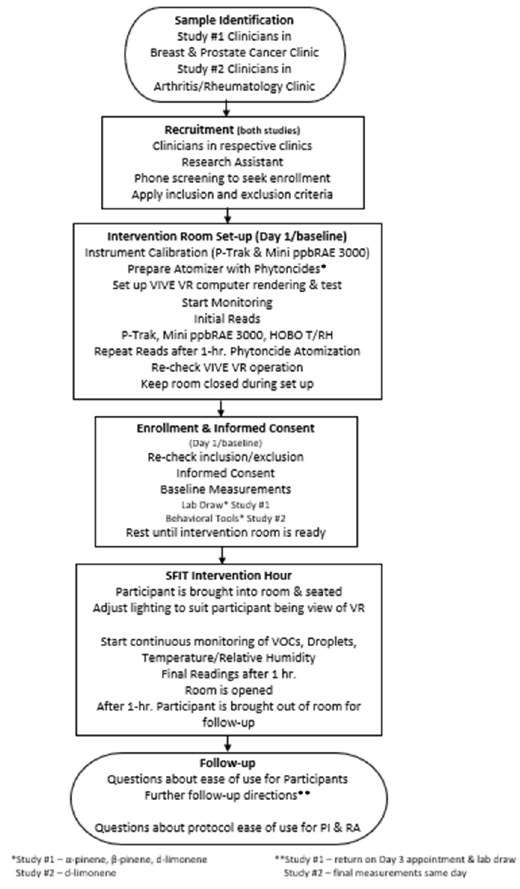
Figure 1. SFIT process/procedure.